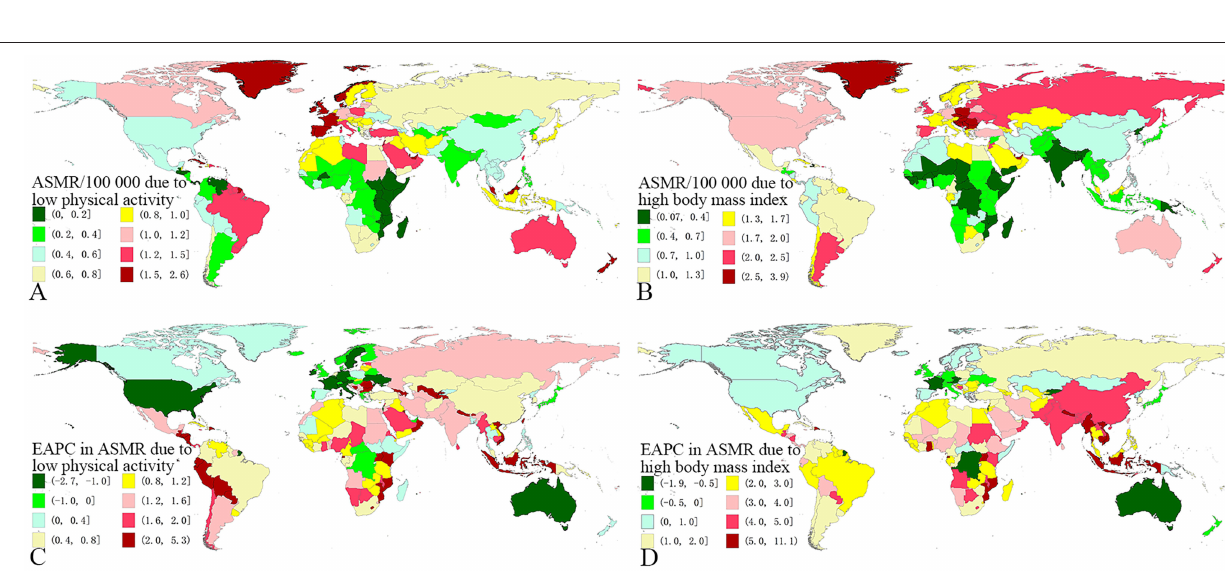
Frontiers in Medicine |